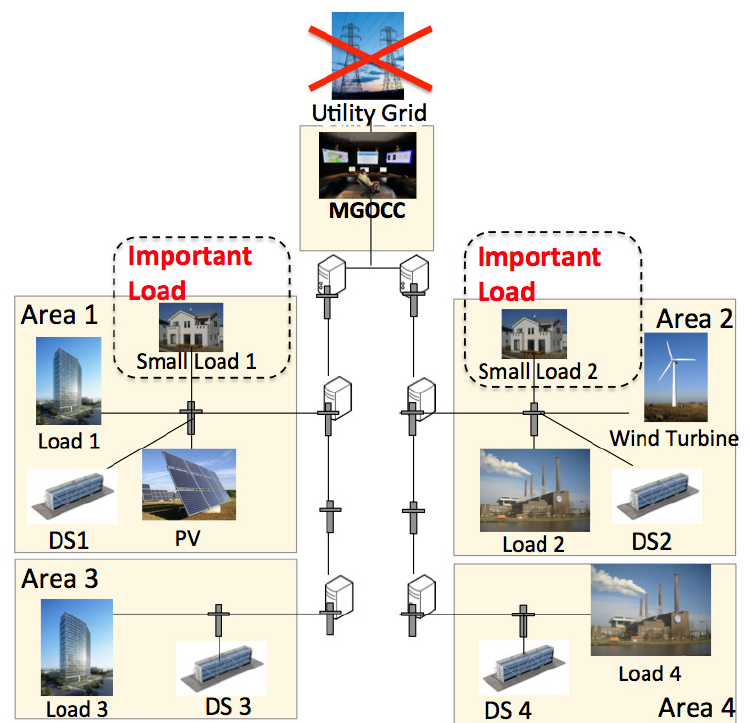
Figure 16. Model of the demonstrated